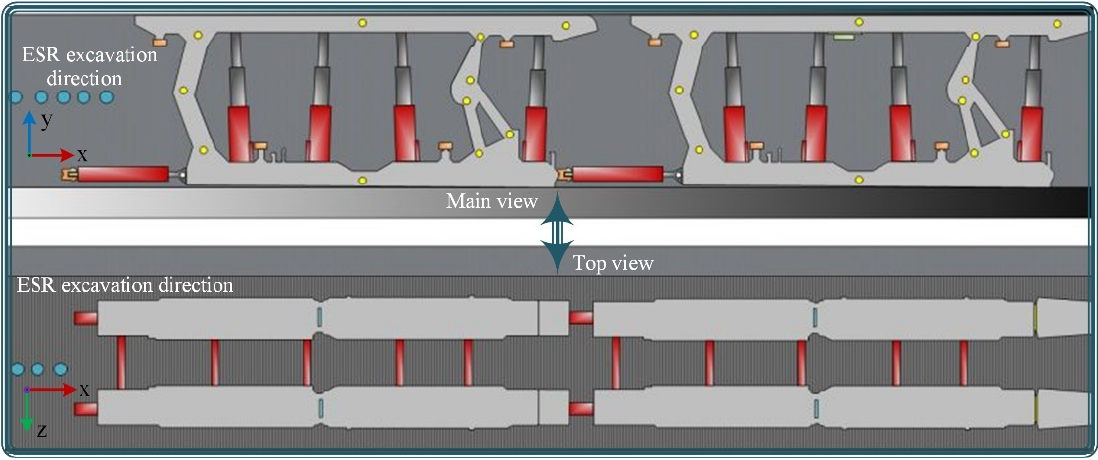
Figure 1. A scenario simulation diagram of the actual operation of the ESR.